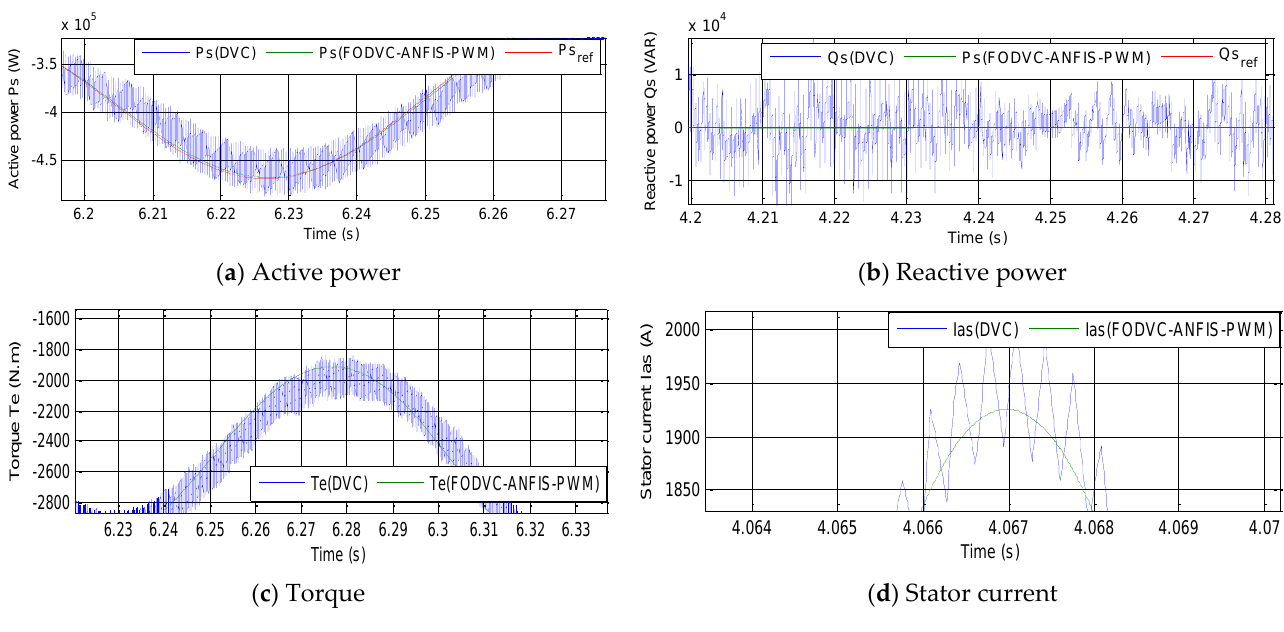
Figure 18. Zoom in the reactive power, active power, torque, and current. Table 3. A comparative study between the two